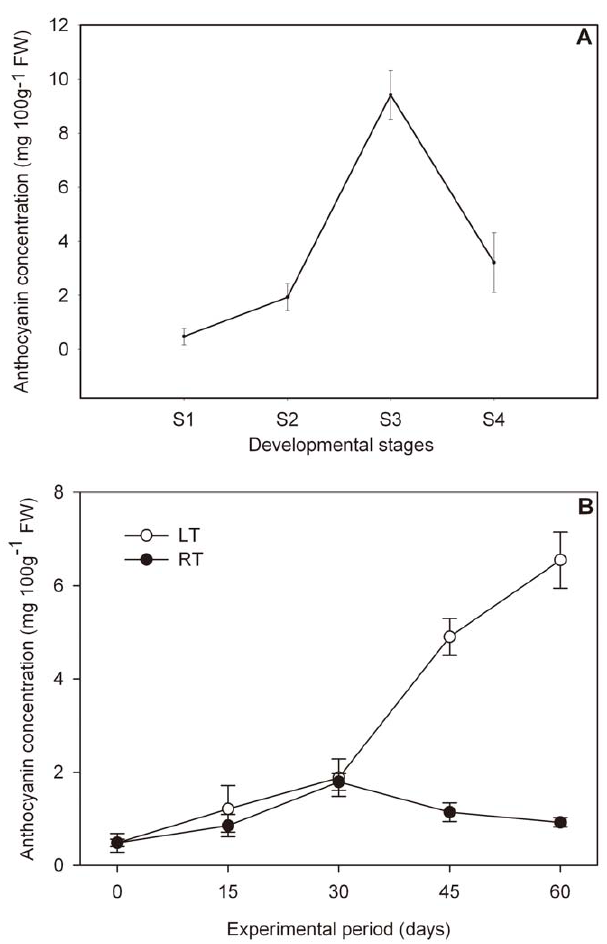
Figure 1. Anthocyanin concentration in ‘Wujiuxiang’ pears. (A): Anthocyanin in pears during ripening; (B): Anthocyanin in pears exposure to LT and RT.